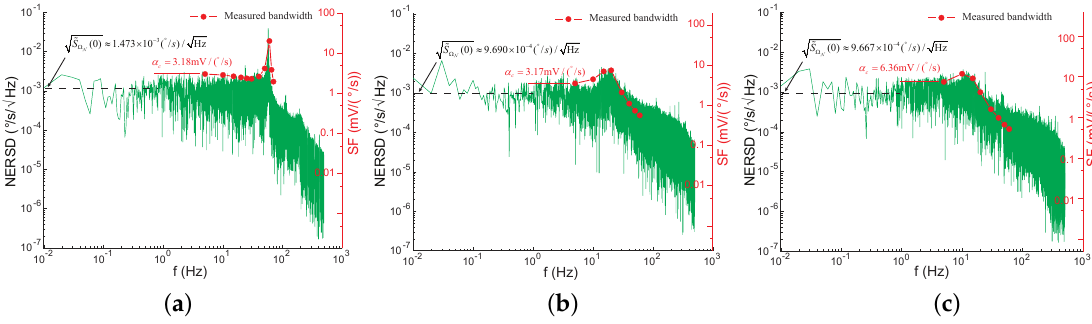
Figure 18. The NER spectral density of the gyroscope in force-rebalance operation. ( a ) In the mode-split case. ( ∆ f = 66Hz); ( b ) In the mode-matched case (The tuning voltage was 8.2 V). ( c ) In the mode-matched case with a half K f